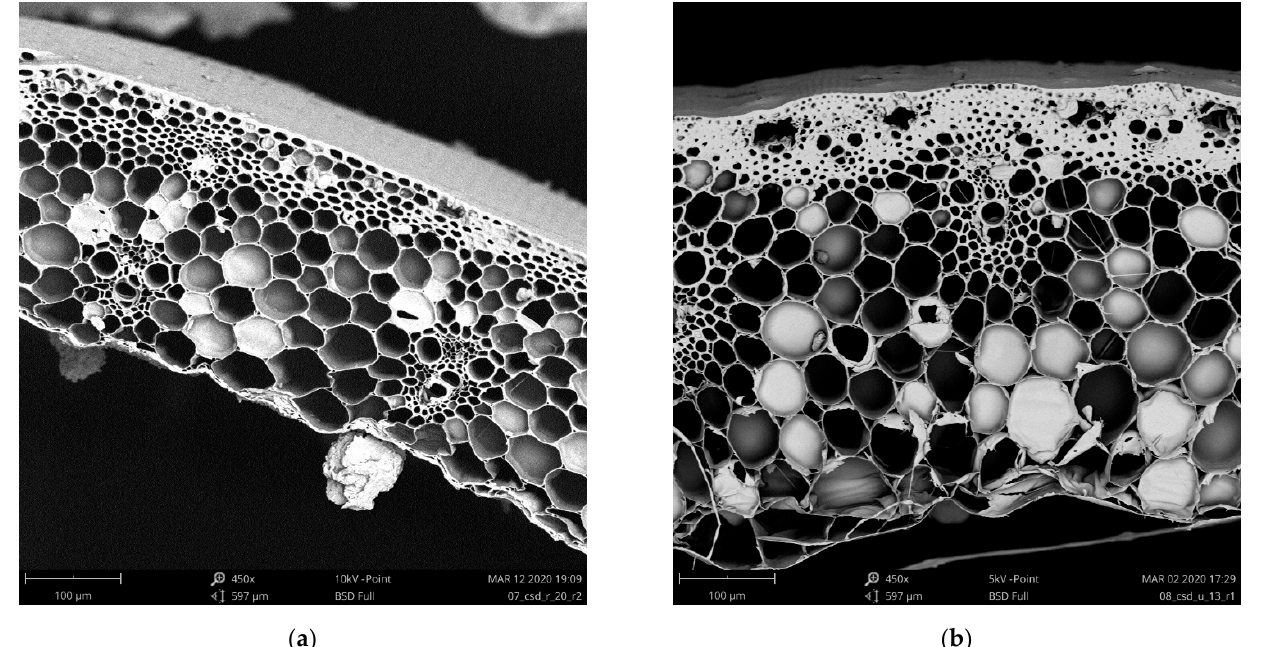
Figure 1. SEM images in 450× magnification of: ( a ) Type-1 straw stem; ( b ) Type-2 straw.